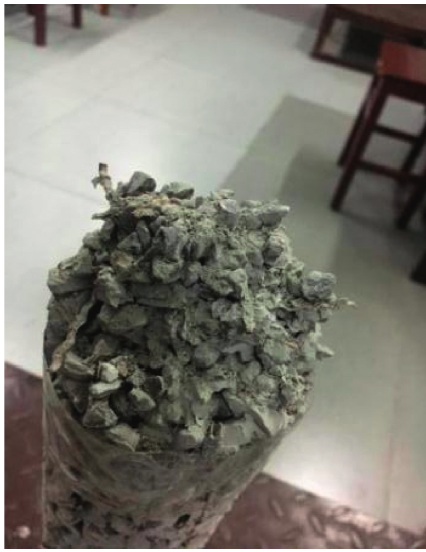
Figure 6: The damaged specimen in the compression test.